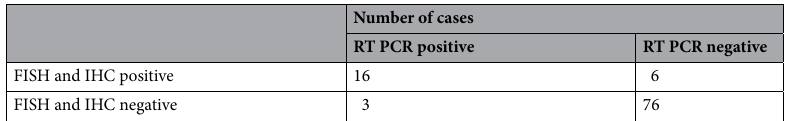
Table 2. Comparison of results of RT-qPCR and IHC/FISH methods used in assessment of ALK